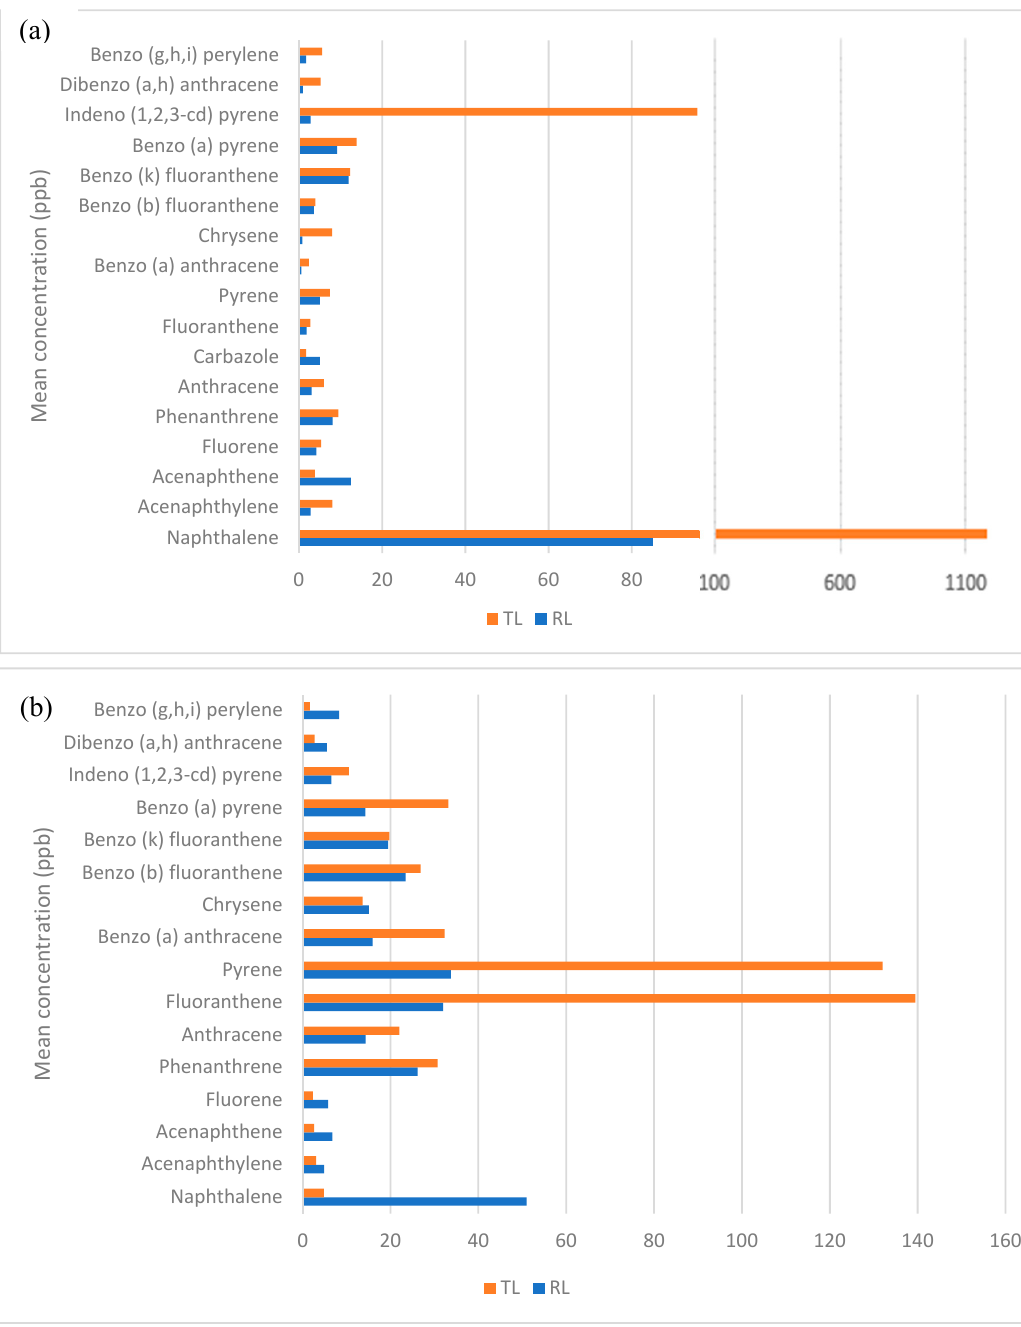
Figure 7 . Mean concentration of PAHs in raw and treated leachate.